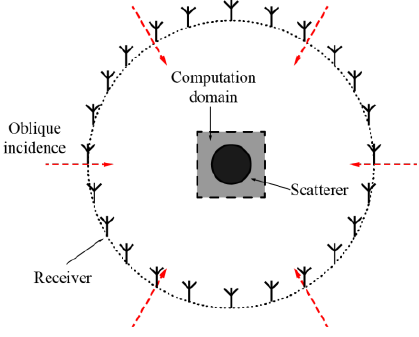
Figure 4. Simulation setup on the x-y plane.